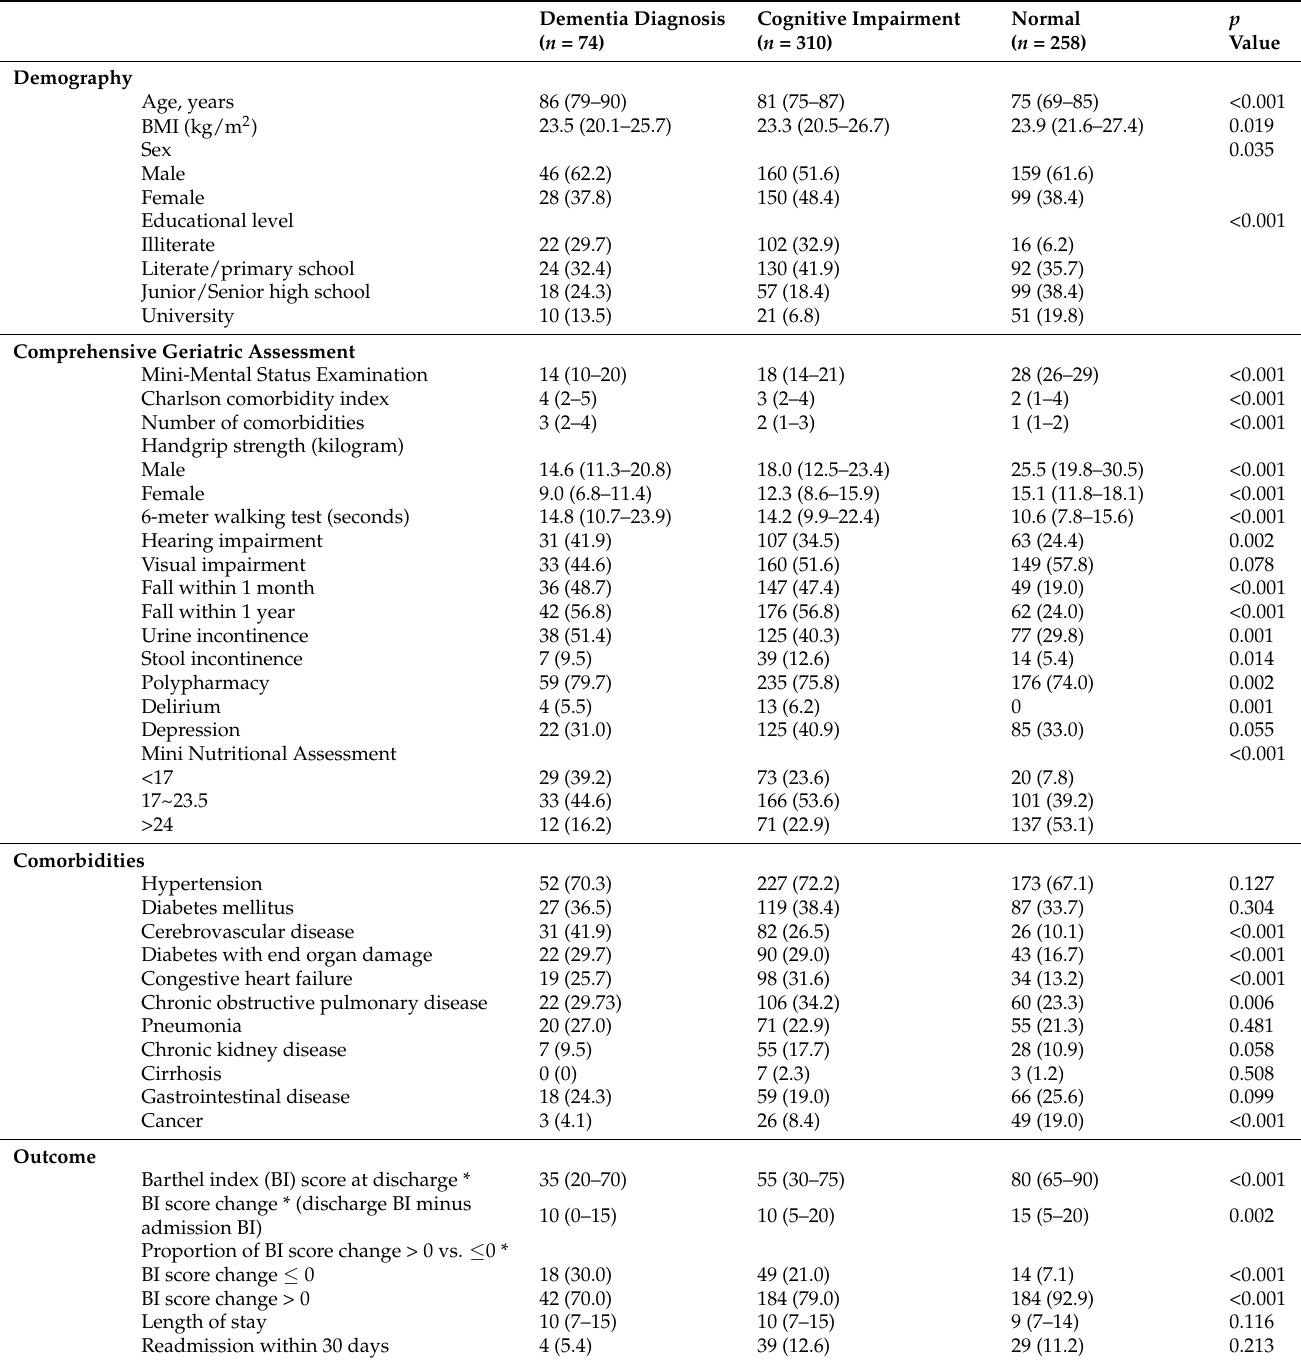
Table 1. Characteristics and outcomes of the